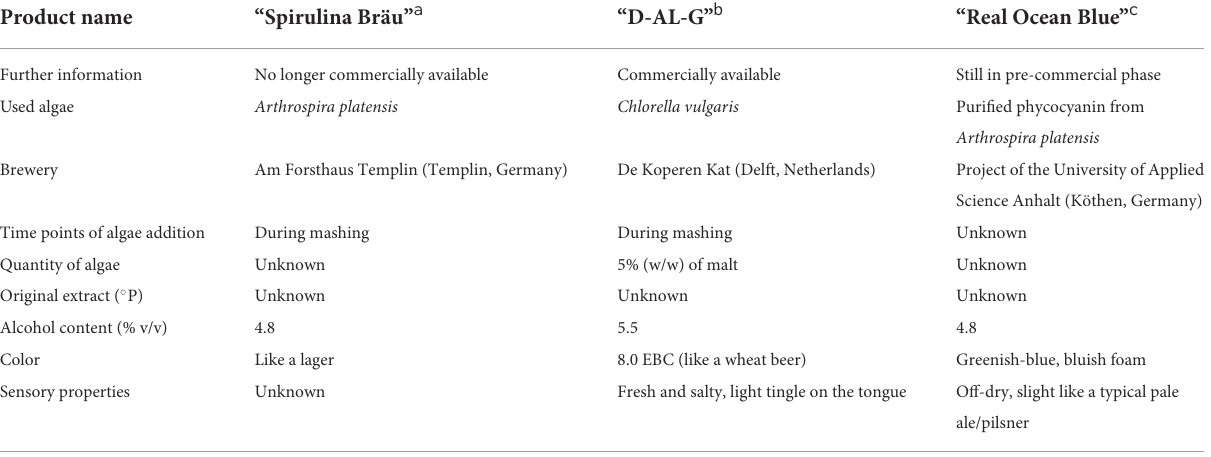
TABLE 1 Specific properties of commercial algae